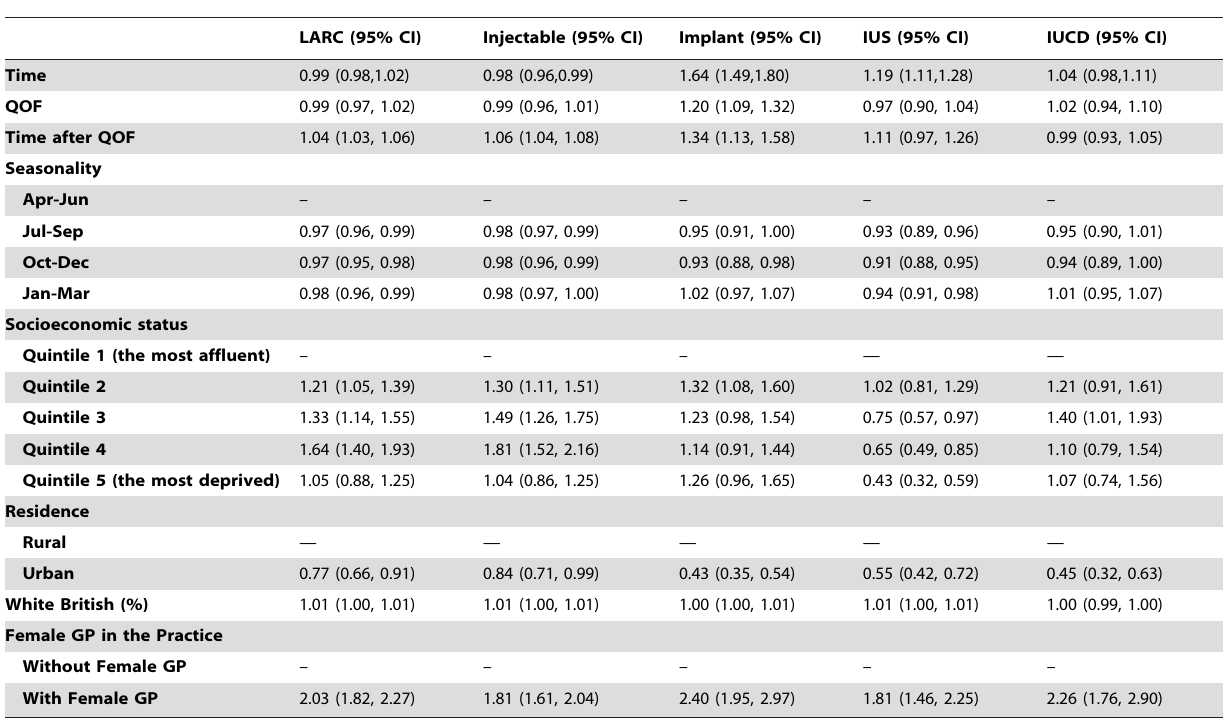
Table 1. Interrupted time-series analysis of LARC prescribing rates in general